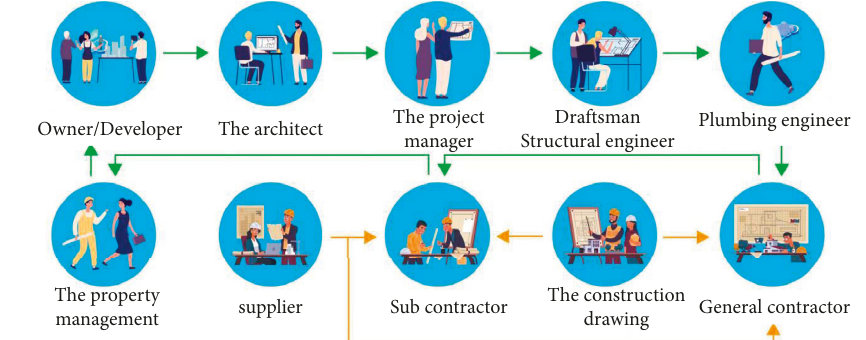
Figure 1: Application of 3D model in building assembly structure.